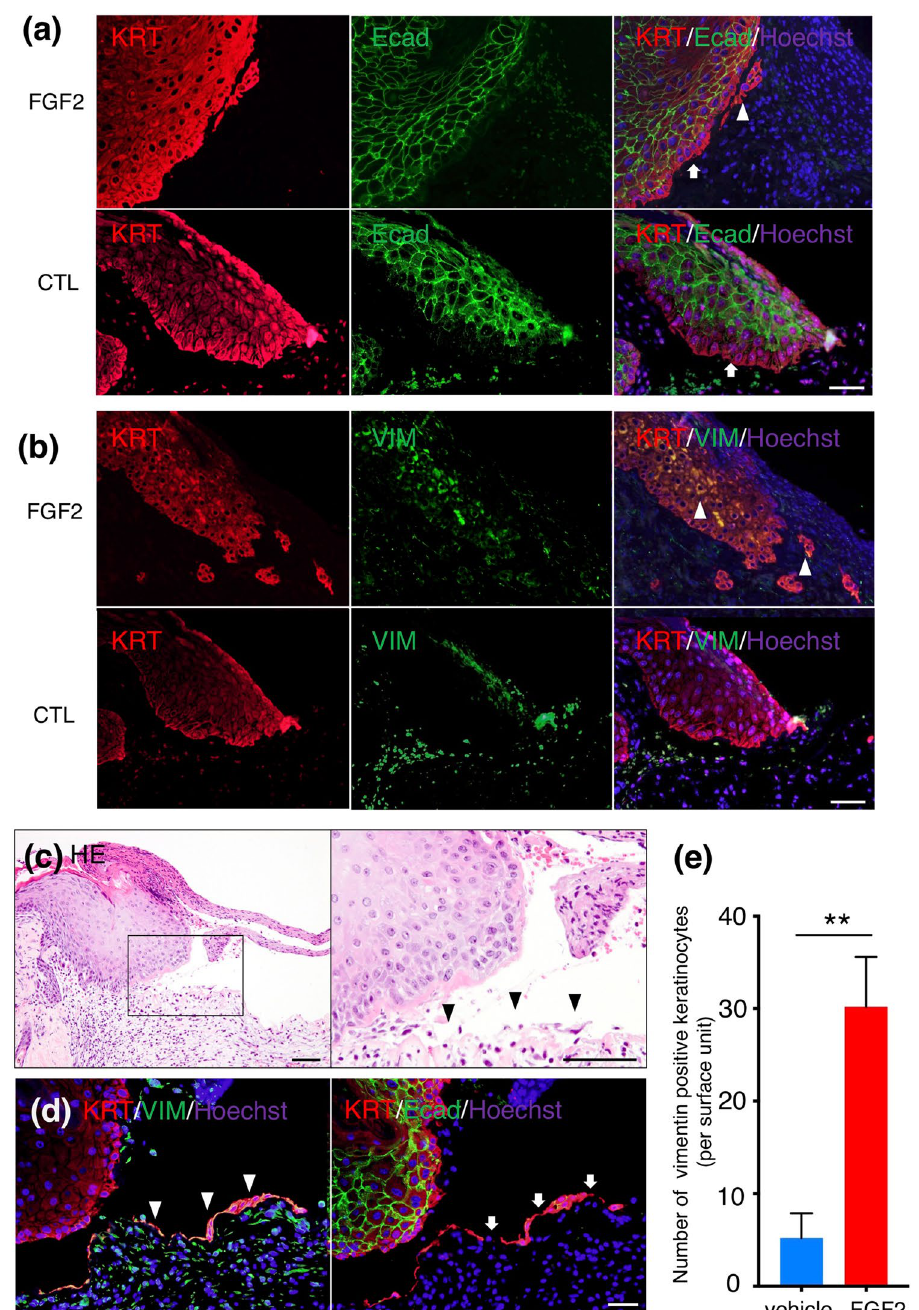
Figure 2. Immunofluorescent staining of wound edges treated with FGF2 or vehicle (control: CTL) after 4 days. ( a ) Cell membrane expression of E-cadherin was reduced in wound edge keratinocytes (arrows) in both FGF2 treated and CTL groups, as well as in keratinocytes away from wound edges in FGF treated group (arrowheads). Scale bar: 20 μm. ( b ) Keratinocytes at the wound edge and during migration in the fibrin clot co-expressed cytokeratin and vimentin (arrowheads) in FGF2 treated group. Scale bar: 20 μm. ( c ) Among HE sections of FGF2-treated wounds, spindle-shaped monolayer keratinocytes (arrowheads) were detected on granulation tissue Scale bar: 40 μm ( d ) and showed were strongly positive for vimentin as well as cytokeratin (arrowheads). In addition, cell membrane E-cadherin was nearly undetectable (arrows). Scale bar: 20 μm ( e ) The number of vimentin-positive wound edge and migrating keratinocytes at the FGF2 treated condition was significantly more than vehicle-treated wounds. Bar graph is presented with the mean values ± standard error. KRT: pan-keratin, Ecad: E-cadherin, VIM: vimentin. ** p < 0.01, Mann–Whitney U